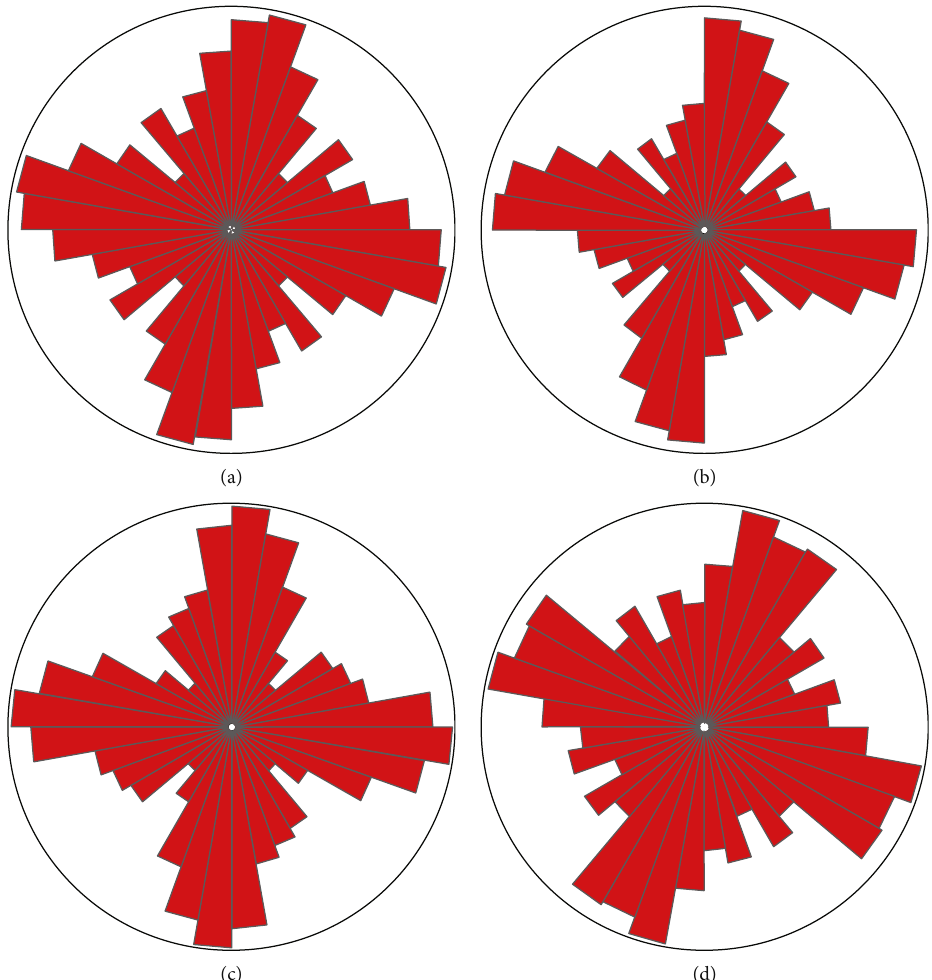
Figure 5: Rose diagram of geoelectric strike based on phase tensor for the whole frequency range (a), more than 10Hz (b), 10-0.1Hz (c), and less than 0.1Hz (d).